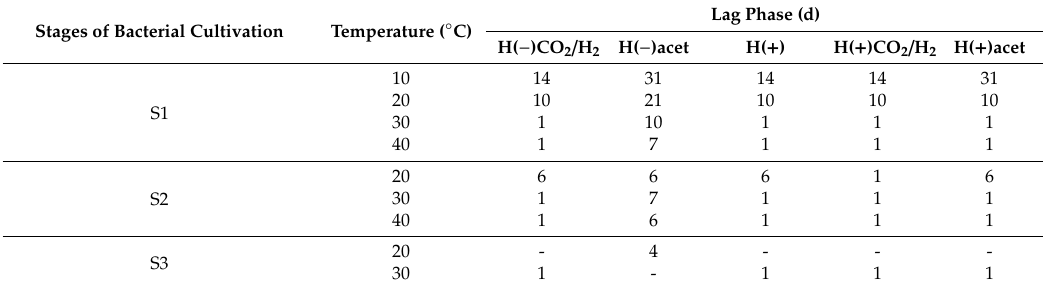
Table 2. Lag phase duration in particular media and stages of enrichment.